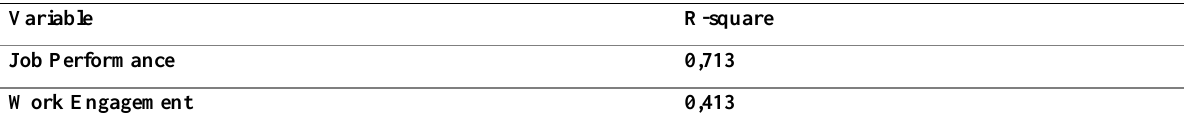
Table 2: Determinant